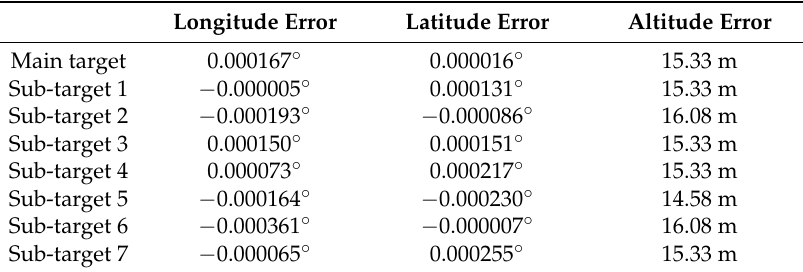
Table 7. Errors of multi-target location after RLS